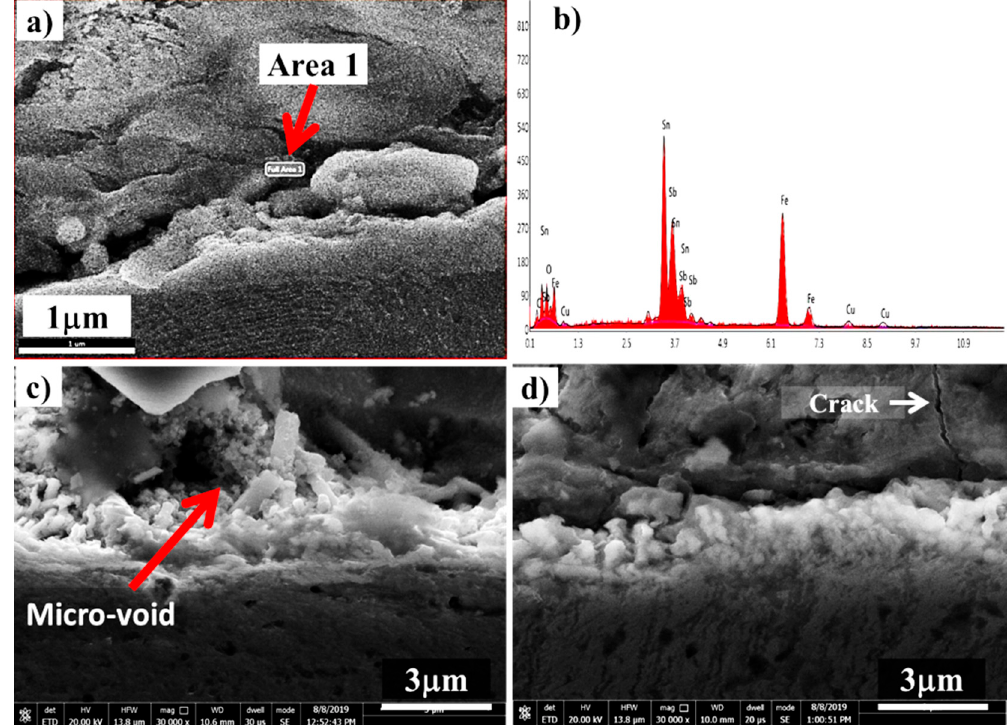
Figure 7. SEM images of interfaces in tin-based Babbitt/steel bimetallic specimens with different loading fractions of alumina nanoparticles in tin-based Babbitt alloy: ( a ) 0 wt%, ( c ) 0.50 wt% and ( d ) 1.0 wt%. ( b ) EDS of tin-based Babbitt interface with 0 wt%.